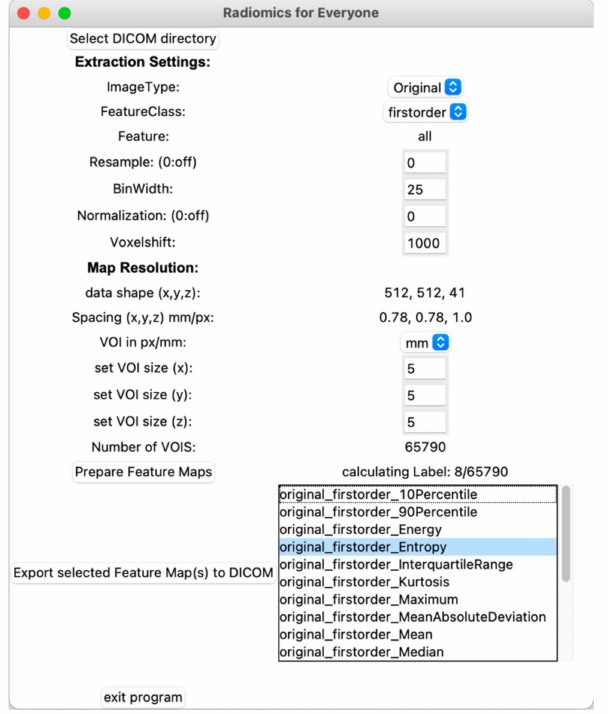
Figure 2. Graphical user interface. After importing the original images, the user can adjust settings for the feature extraction and define the resolution of the parametric map. Once the features are calculated, parametric maps can be exported in the DICOM format by choosing the feature from a